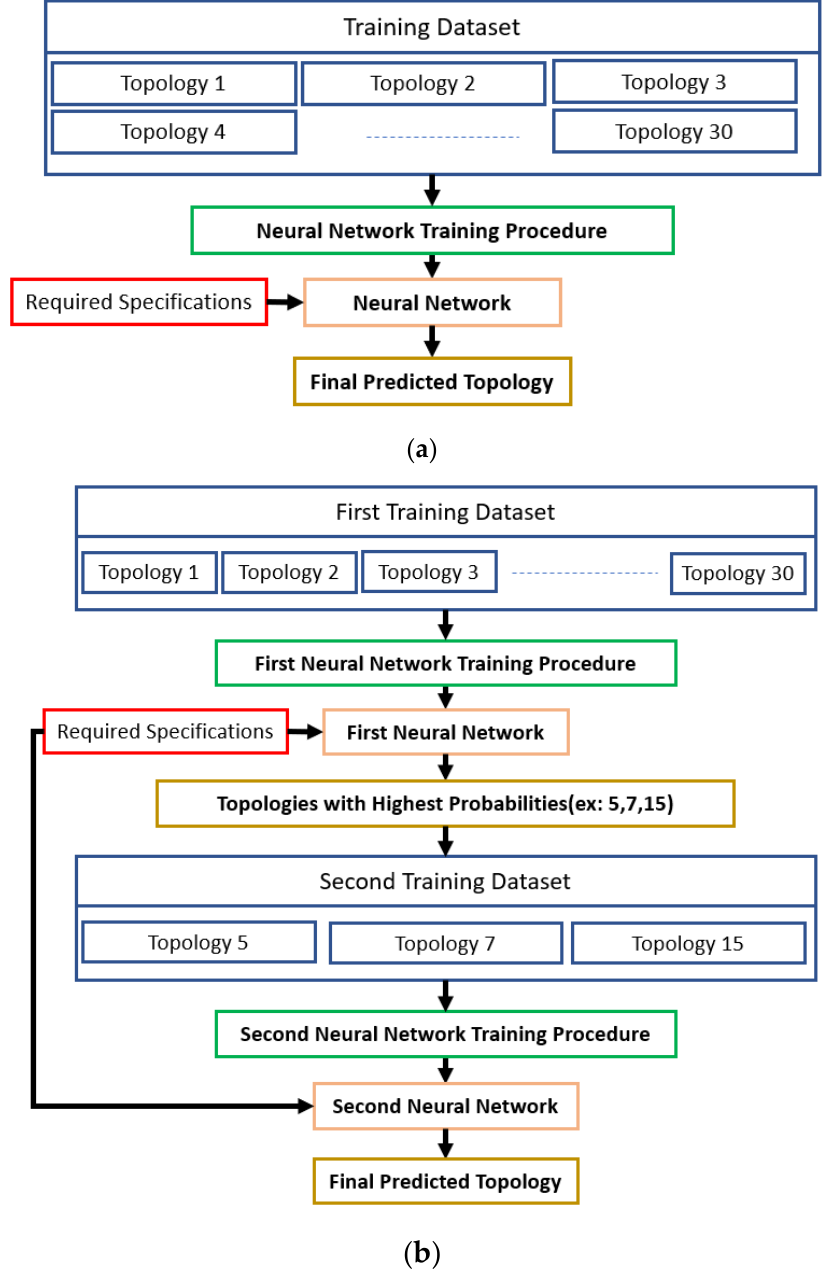
Figure 1. A flow chart explaining the methodology of the first and the second approaches for the topology selection: ( a ) Methodology of the first approach; ( b ) Methodology of the second approach.